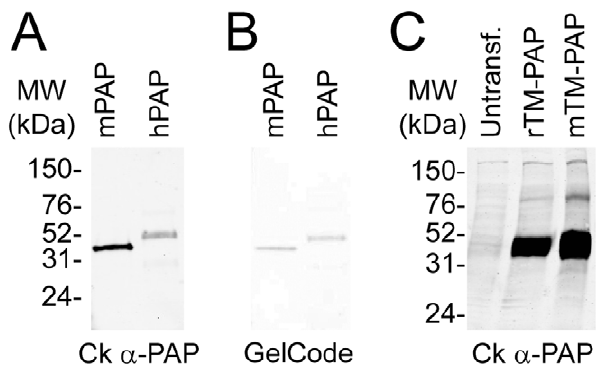
Figure 1. Chicken antibody detects mouse, rat and human PAP on western blots. (A) Western blot containing purified recombinant mPAP protein and pure hPAP protein probed with chicken (Ck) anti-PAP antibody. (B) Duplicate gel stained with GelCode blue to confirm that equivalent amounts of protein were loaded. (C) Western blot of cell lysates from untransfected HEK 293 cells and HEK 293 cells transfected with rTM-PAP or mTM-PAP.